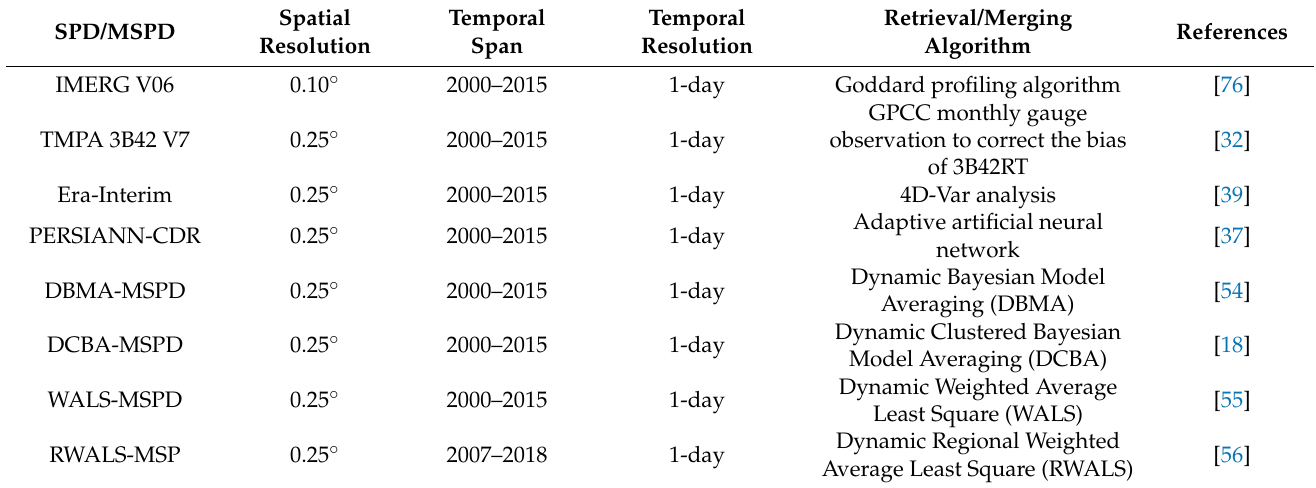
Table 1. Description of SPDs and MSPDs used for monitoring drought.